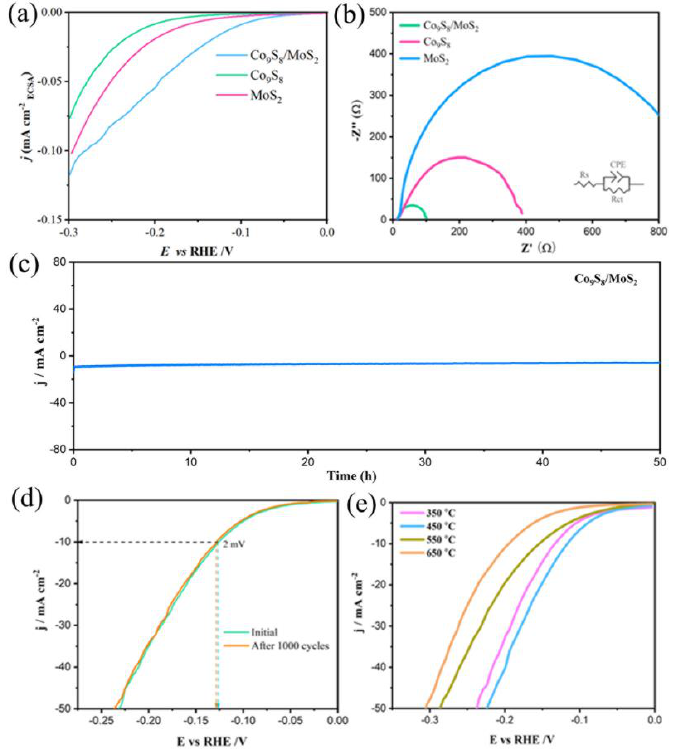
Figure 9. ( a ) Polarization curves normalized to the ECSA of Co 9 S 8 , MoS 2 , and Co 9 S 8 /MoS 2 ; ( b ) Nyquist plots for Co 9 S 8 , MoS 2 , and Co 9 S 8 /MoS 2 ; ( c ) chronoamperometric curve for Co 9 S 8 /MoS 2 ; ( d ) polarization curves of Co 9 S 8 /MoS 2 before and after 1000 CV cycles; ( e ) polarization curves of Co 9 S 8 /MoS 2 after vulcanization of CoMo-LDH at different temperatures in 1 M KOH.